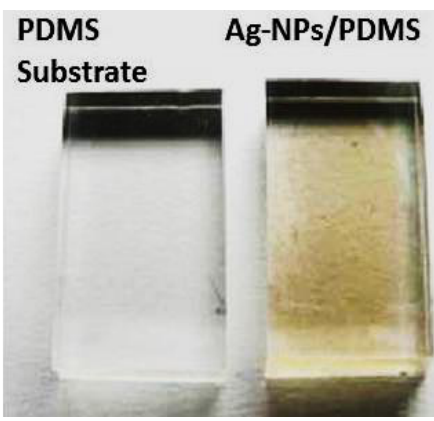
Figure 4. Thin-layer coats of Ag-NP ink on the PDMS substrate.